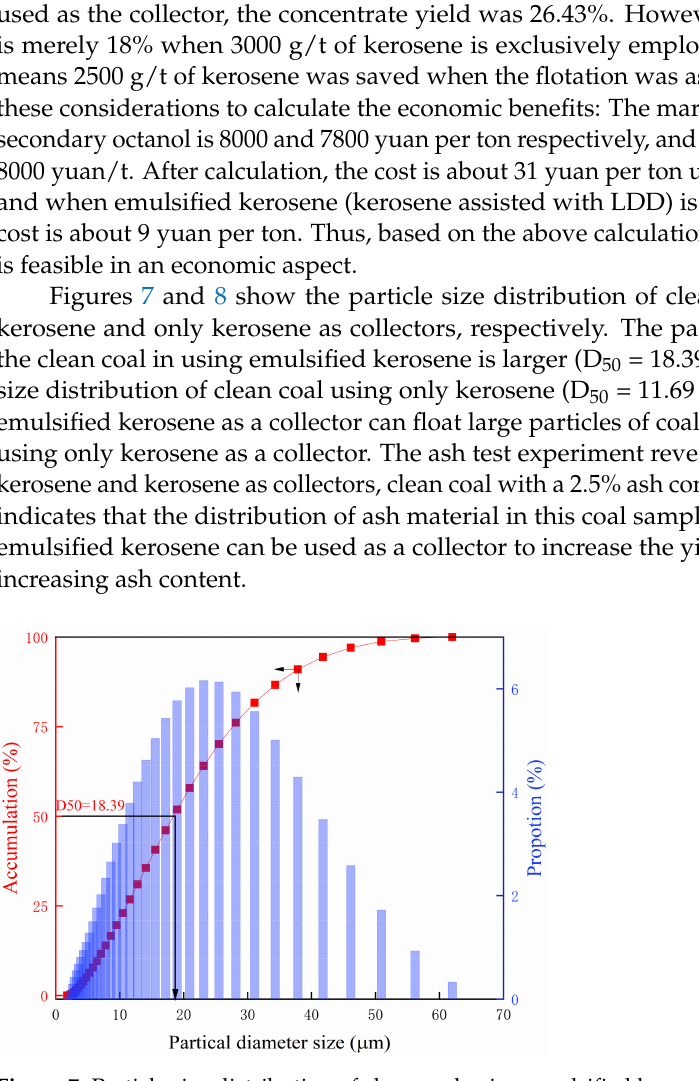
Figure 7. Particle size distribution of clean coal using emulsified kerosene as a